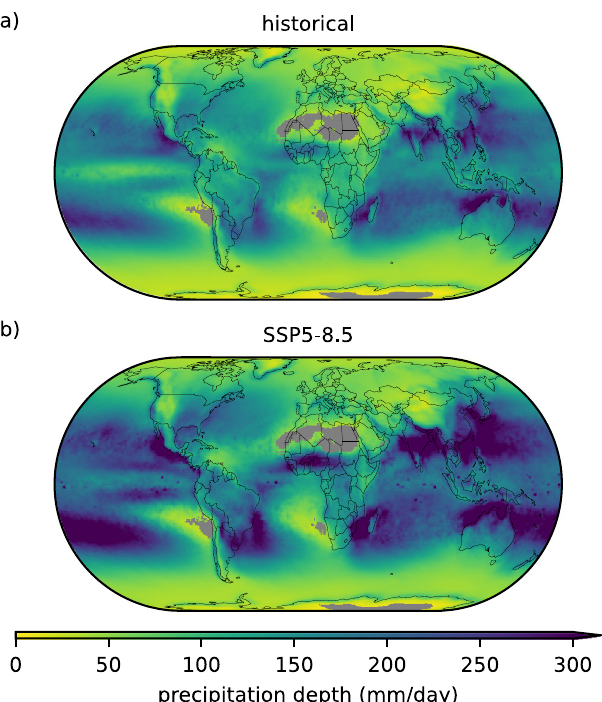
Fig. 1 The 100-year return level of daily precipitation. The 100-year return level of daily precipitation weighted mean across 25 CMIP6 models for a historical (1971 – 2000) and b SSP5-8.5 future (2071 – 2100) periods. The individual model results are shown in Supplementary Figs. S4 and S5. Dry areas (weighted mean of less than 3 events per year) are masked in